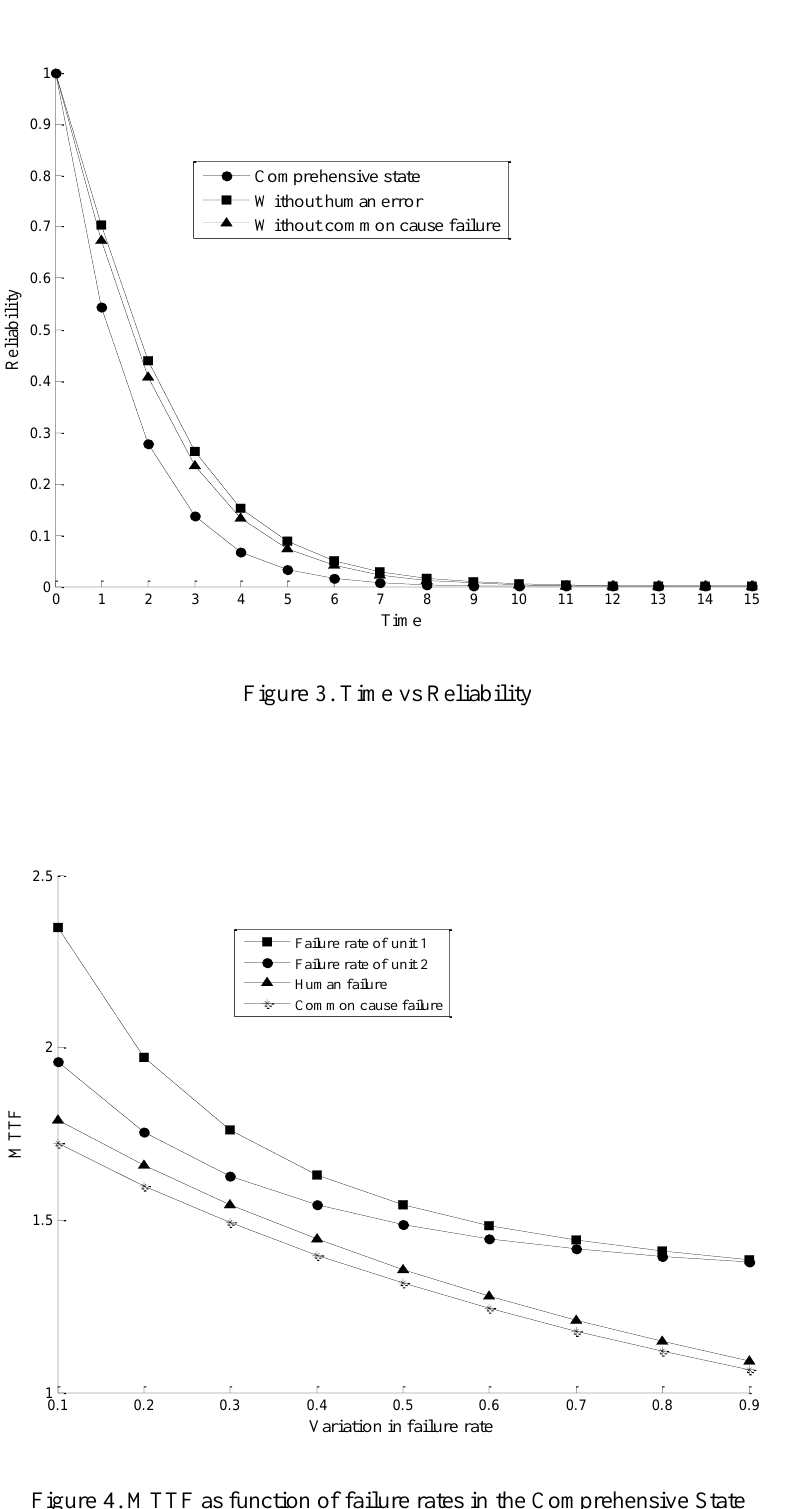
Figure 4. MTTF as function of failure rates in the Comprehensive